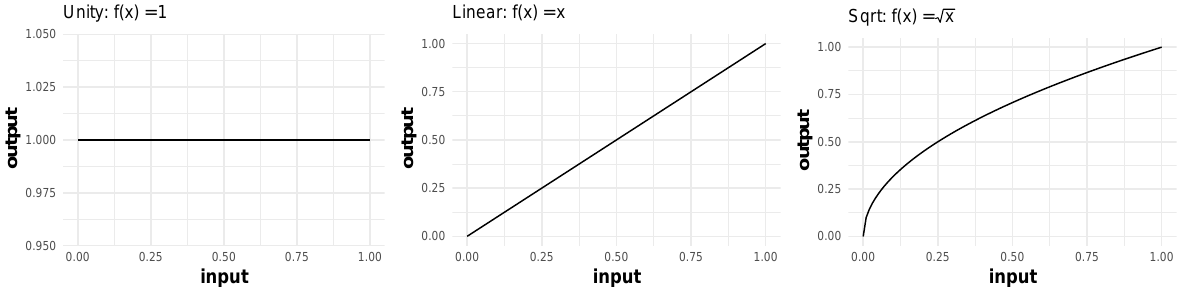
Figure 3. Three functions used as a priority function for calculating Citation Ratio series